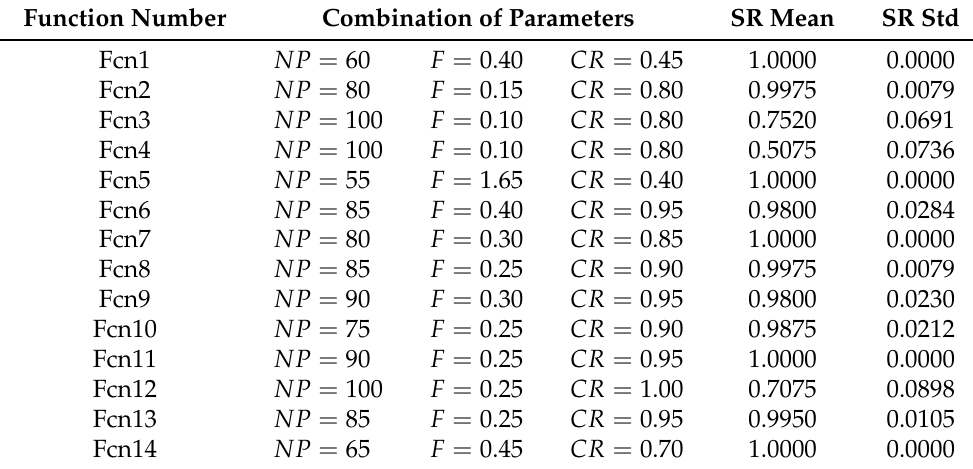
Table 7. Experimental results by DE algorithm for 24 BBOB objective functions with their respective parameter values. The mean (SR mean) and standard deviation (SR std) values of SR are calculated over 10 DE algorithm independent